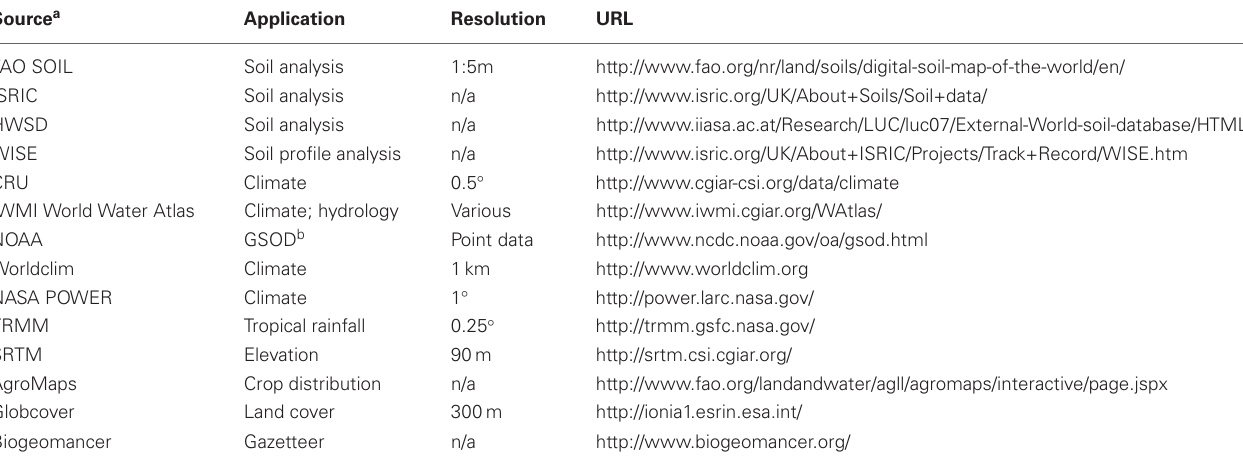
Table 1 | Key spatial data sets that are publicly